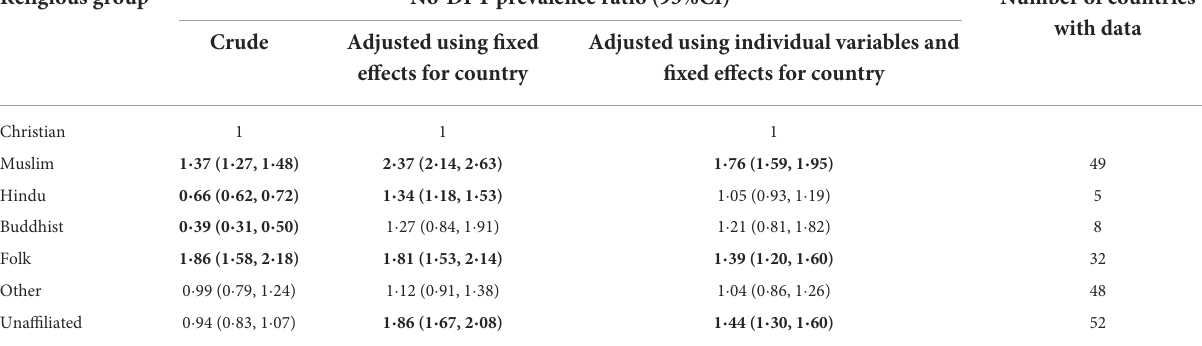
Boldresultssignal95%confidenceintervalsthatdonotincludetheunity.